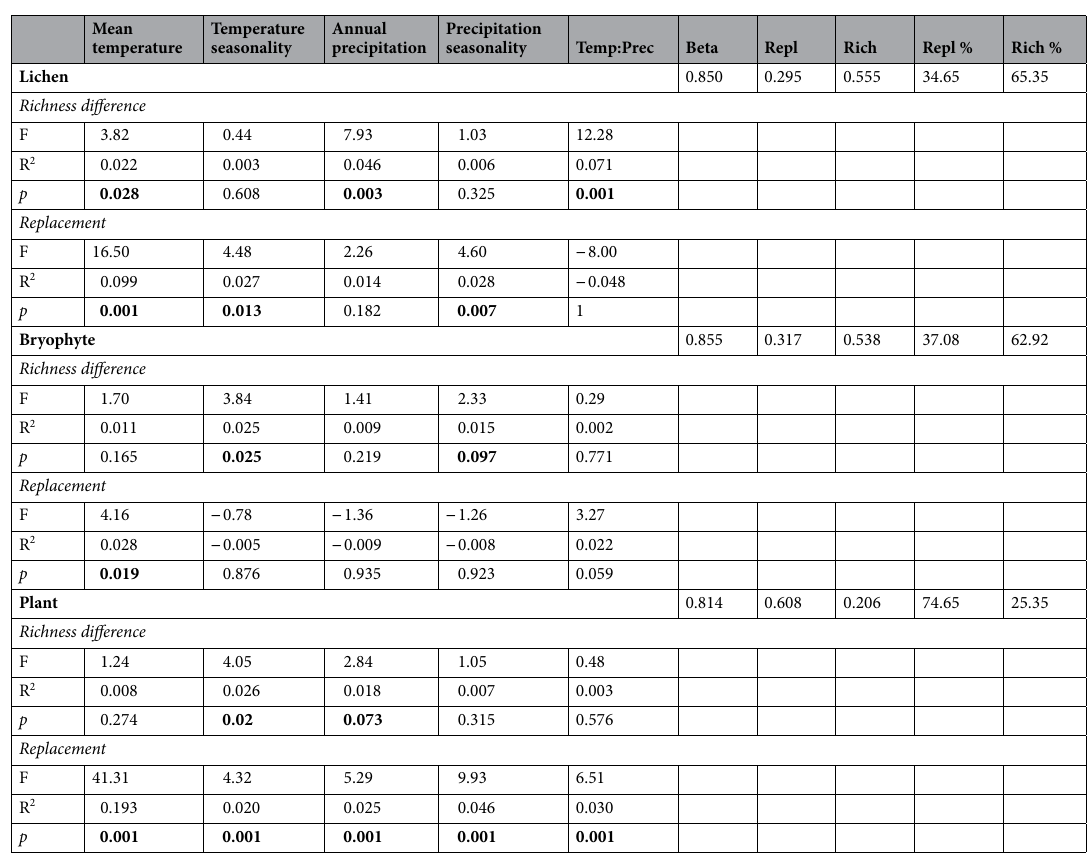
Table 3. Left half table: results of PERMANOVA on the two components of Beta-diversity. R 2 the percentage of variation explained in a model, F the F statistic. Significant p values are reported in bold. Right half of the table: partitioning of Beta-diversity (Beta) into species replacement (βrepl) and richness difference (βrich), expressed as pure value and proportion of the total beta-diversity